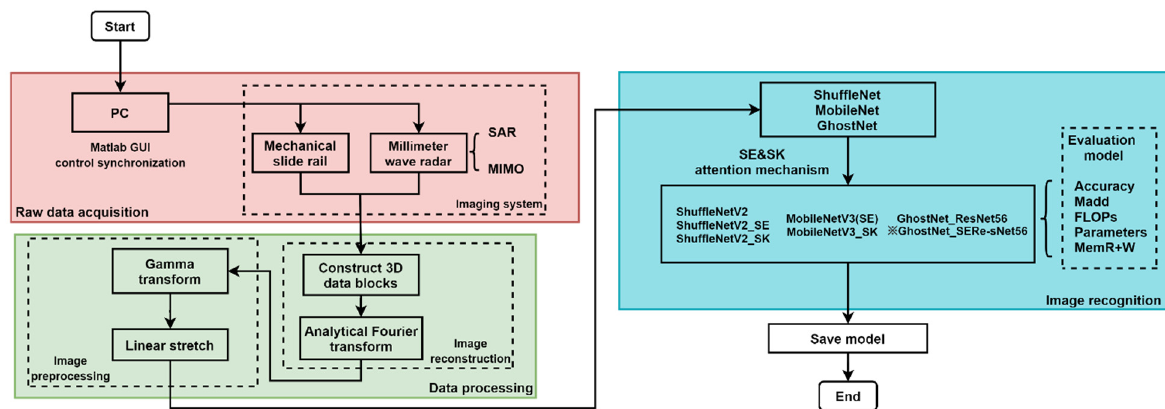
Figure 1. Flow chart of millimeter wave radar imaging and target recognition system.